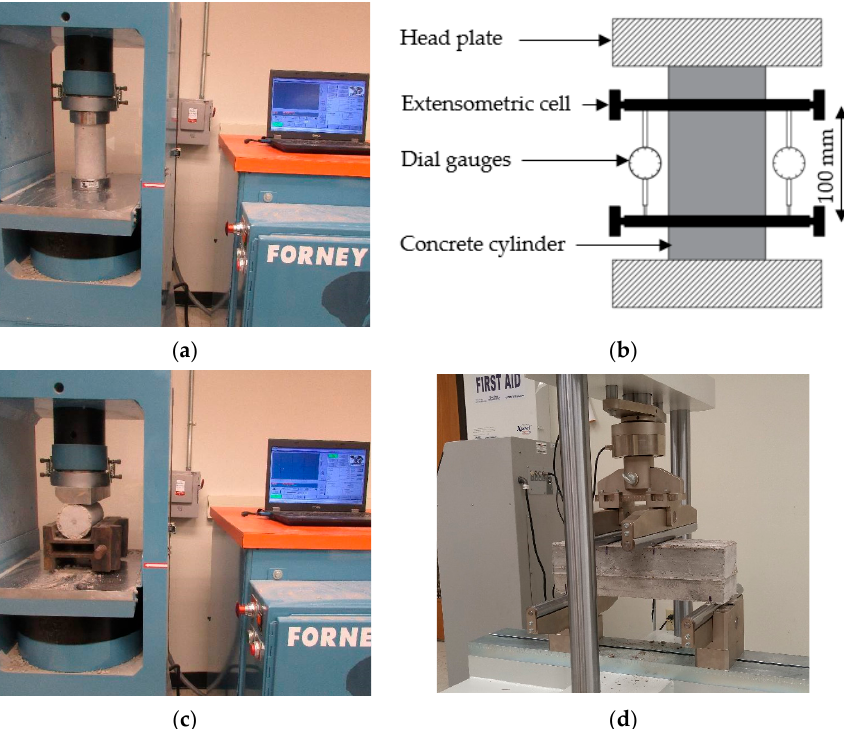
Figure 5. Types of equipment for compression, splitting, and flexural tests. ( a ) Uniaxial compression tests. ( b ) Axial strain measurements. ( c ) Splitting tests. ( d ) Flexural tests.